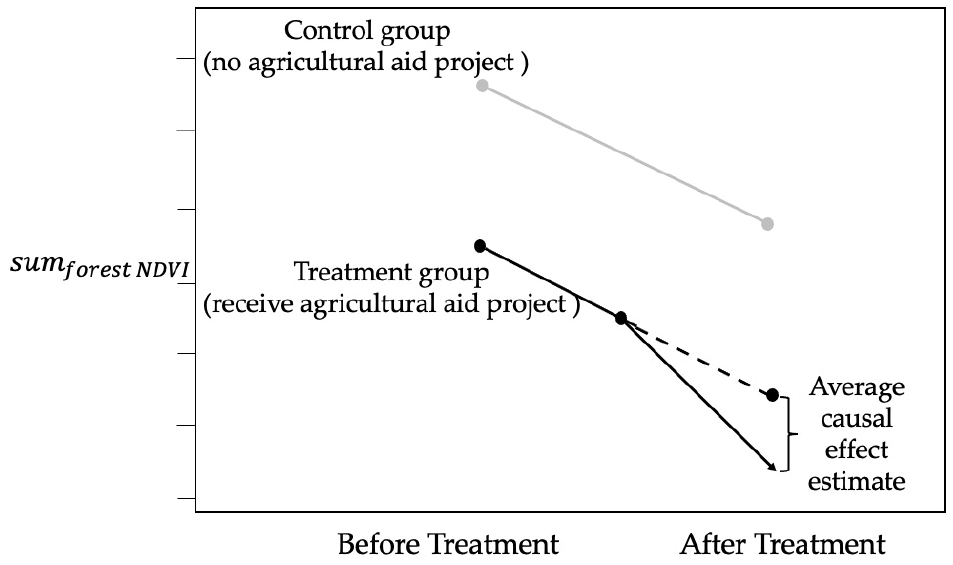
Figure 3. Illustration of the difference-in-difference approach.